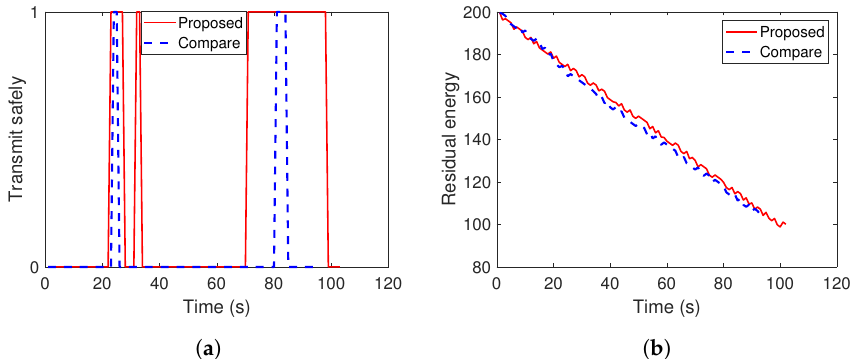
Figure 6. Simulation results of when the UAV can securely transmit data ( a ) and the residual energy ( b ) in case 1.